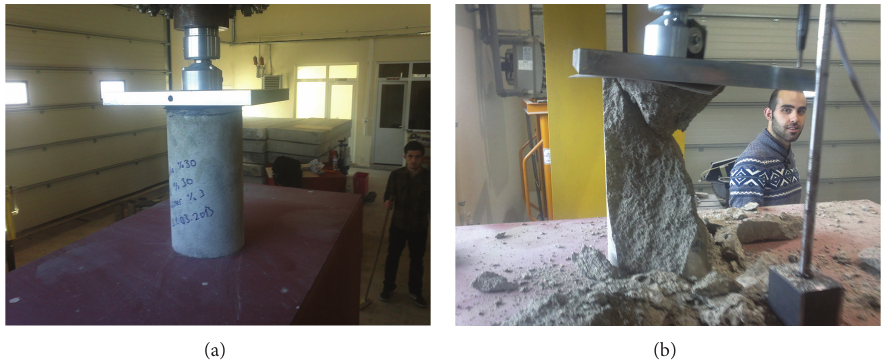
Figure 3: Arrangement of specimen for compressive test in lab.